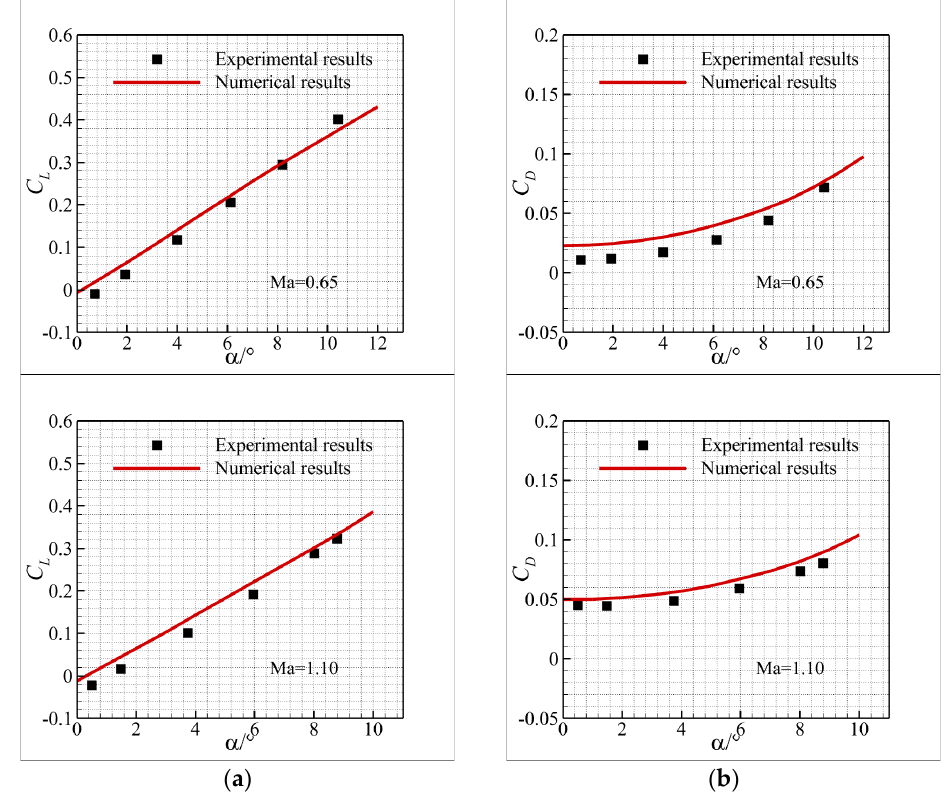
Figure 4. Comparison of the experimental and numerical results at Ma = 0.65, 1.1 and Re = 8.2 × 10 6 . ( a ) Lift coefficient; ( b ) Drag coefficient.